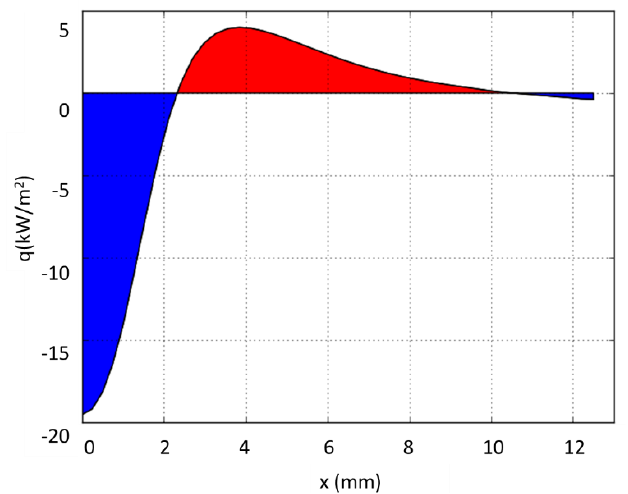
Figure 10. Convective Heat Flux in the specimen surface as a function of the distance to the center for the P1 line. (red area is positive heat transfer zone and blue area is negative heat transfer zone)